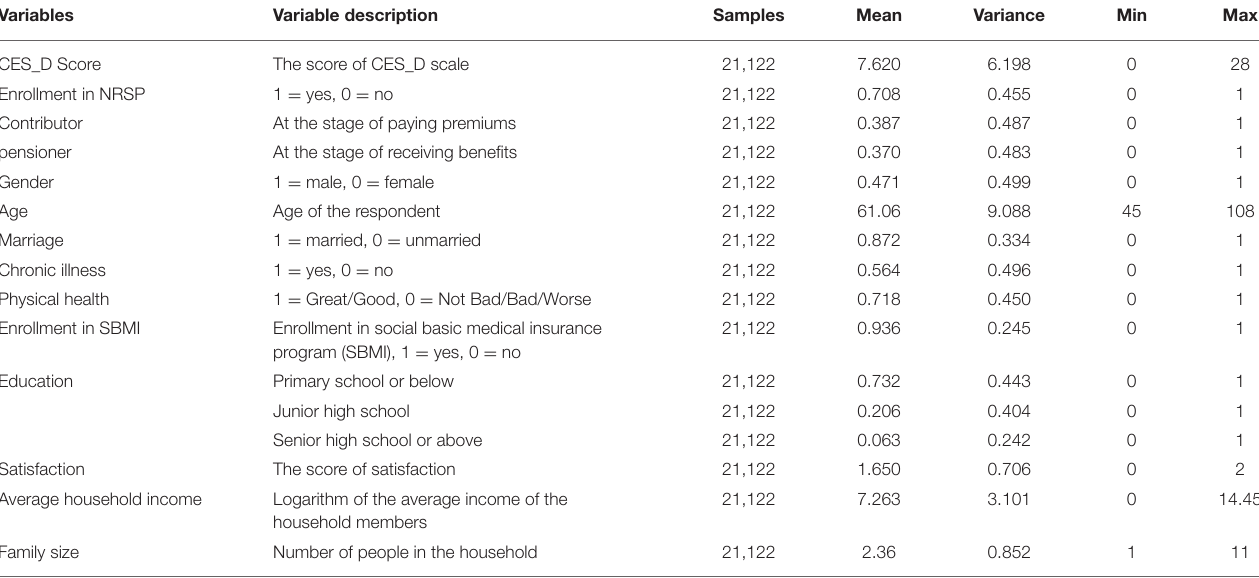
TABLE 1 | Descriptive